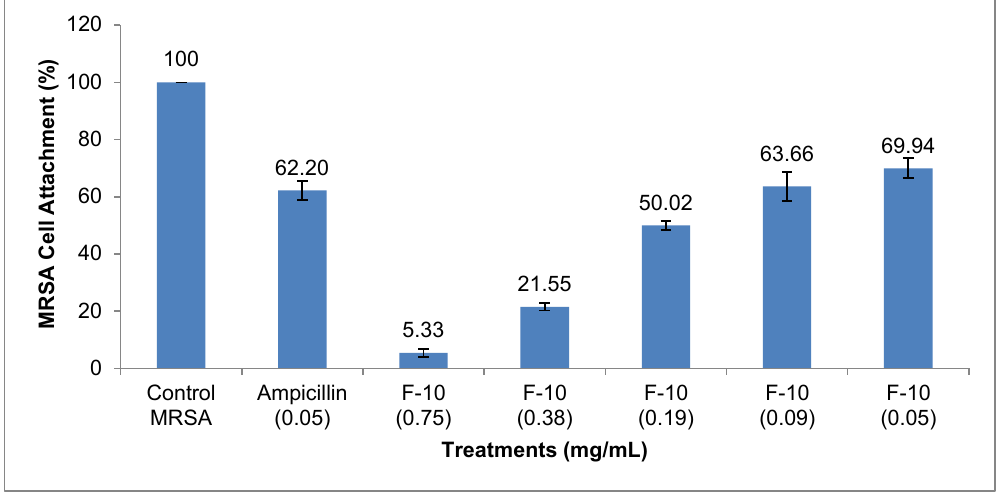
Figure 3. Attachment of MRSA cells to the surfaces of microtiter plate wells containing F-10 and ampicillin. Three wells were used for each treatment. Experiment is representative of three independent tests, and error bars indicate the standard deviation. All differences between control and treated MRSA were statistically significant ( p < 0.001).